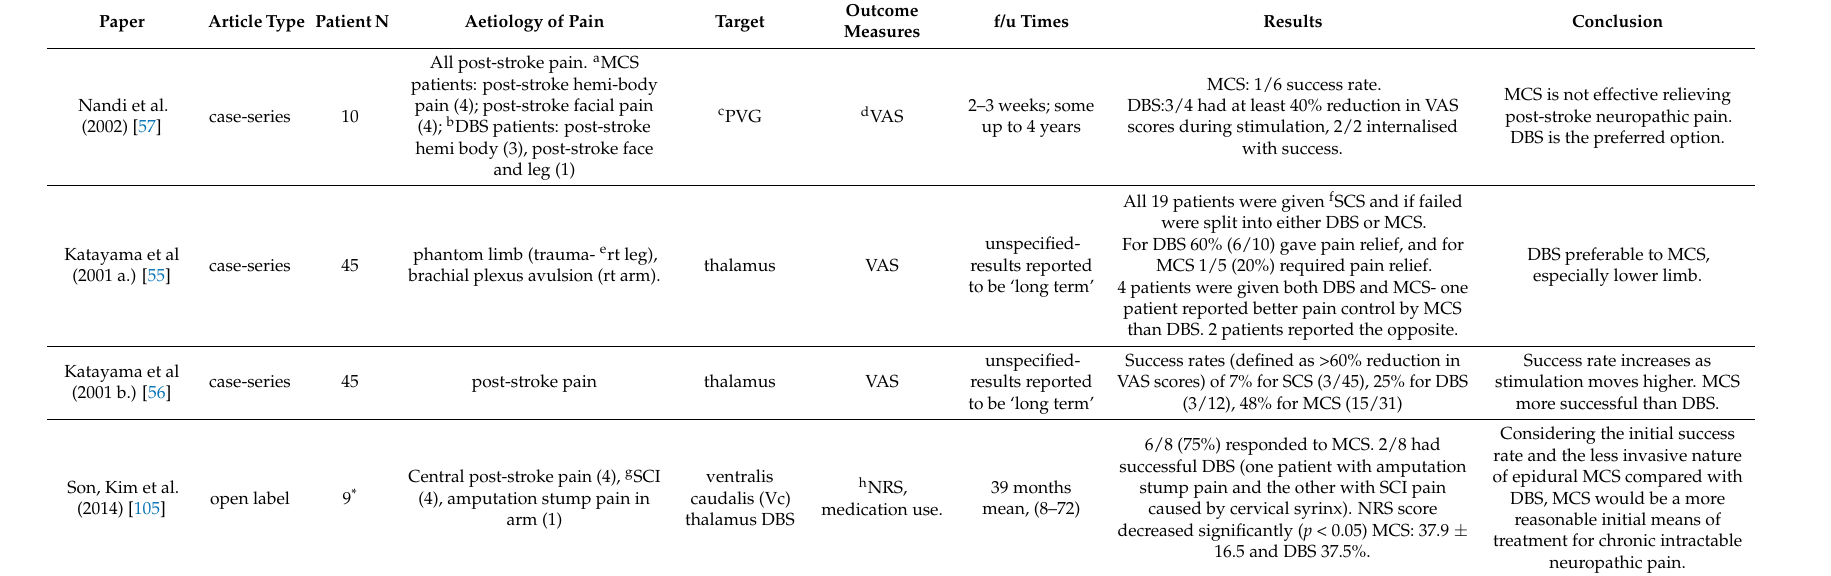
Table 2. Studies involving comparison of Motor Cortex Stimulation and Deep Brain